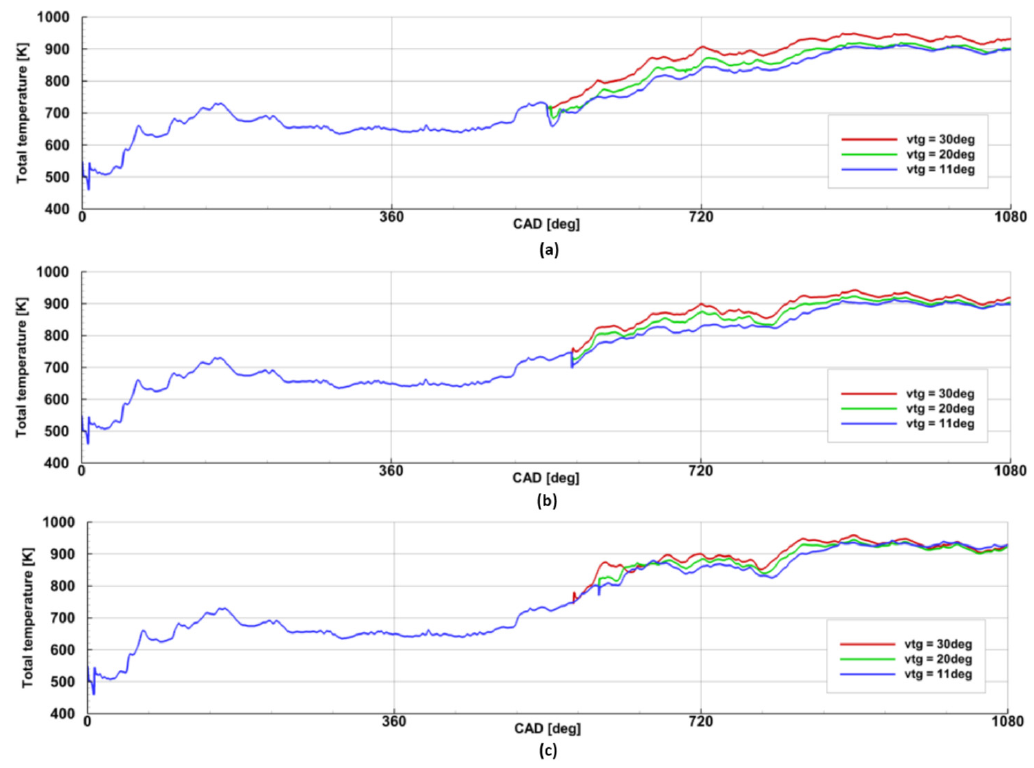
Figure 20. The outlet total temperature variation at the 2nd stage rotor at the three different VTG openings for: ( a ) 60,000 rpm, ( b ) 50,000 rpm, ( c ) 40,000